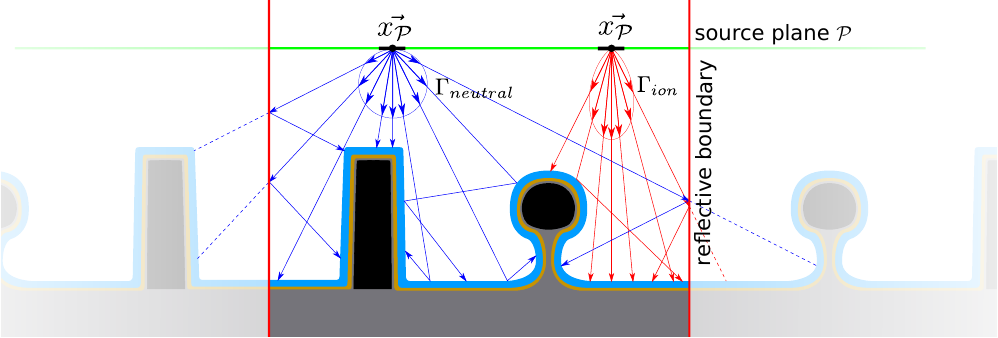
Figure 7. Schematic depiction of discrete particles being traced from the source plane to the surface using rays. Each particle either describes neutral atoms or molecules (blue) or ions (red), governed by the source distributions Γ neutral and Γ ion , respectively. They define the relative probability of particle direction, energy and other properties. Specular reflections are shown for ions, and diffuse reflections for neutral